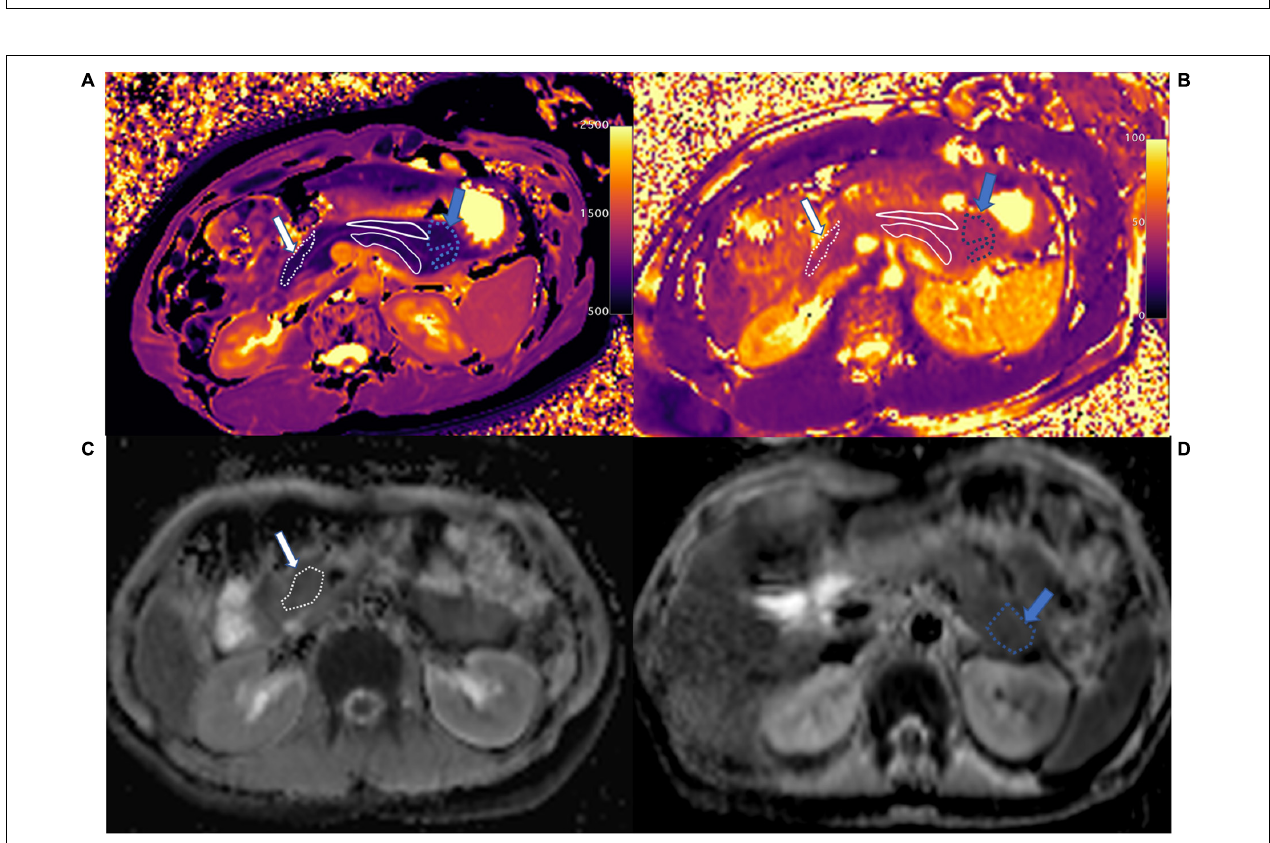
FIGURE 4 | T1 mapping (A) , T2 mapping (B) , and ADC maps (C,D) of normal control pancreatic head (white arrow and area), body (white solid line area), and tail (blue arrow and area). The whole pancreas had the homogenous T1 (head: 798.2 ± 80.5 ms, body: 832.0 ± 83.5 ms, and tail: 835.2 ± 49.7 ms), T2 (head: 45.6 ± 6.5 ms, body: 44.4 ± 4.0 ms, and tail: 45.8 ± 2.2 ms), and ADC (head: 1.206 ± 0.069 mm 2 /s, body: 1.141 ± 0.183 mm 2 /s, and tail: 1.061 ± 0.108 mm 2 /s) values in the head, body, and tail. The main pancreatic duct (MPD) shows clearly on T1 mapping, which differs from the pancreatic head and tail.